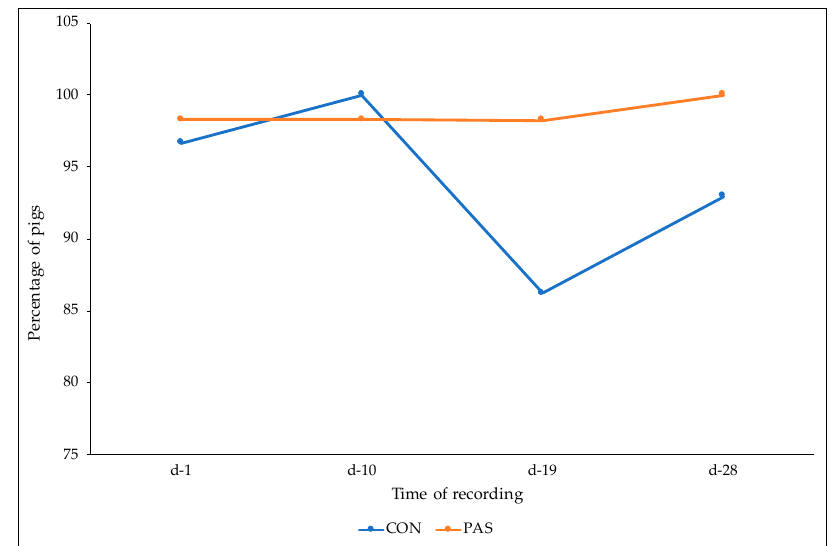
Figure 3. Proportion (%) of pigs from CON and PAS diets not affected by ear lesions (score 0) at different times of recording. CON: control animals receiving only the basal diet without natural extract supplementation; PAS: animals receiving the control diet supplemented with Passiflora incarnata extract (1 kg/t).